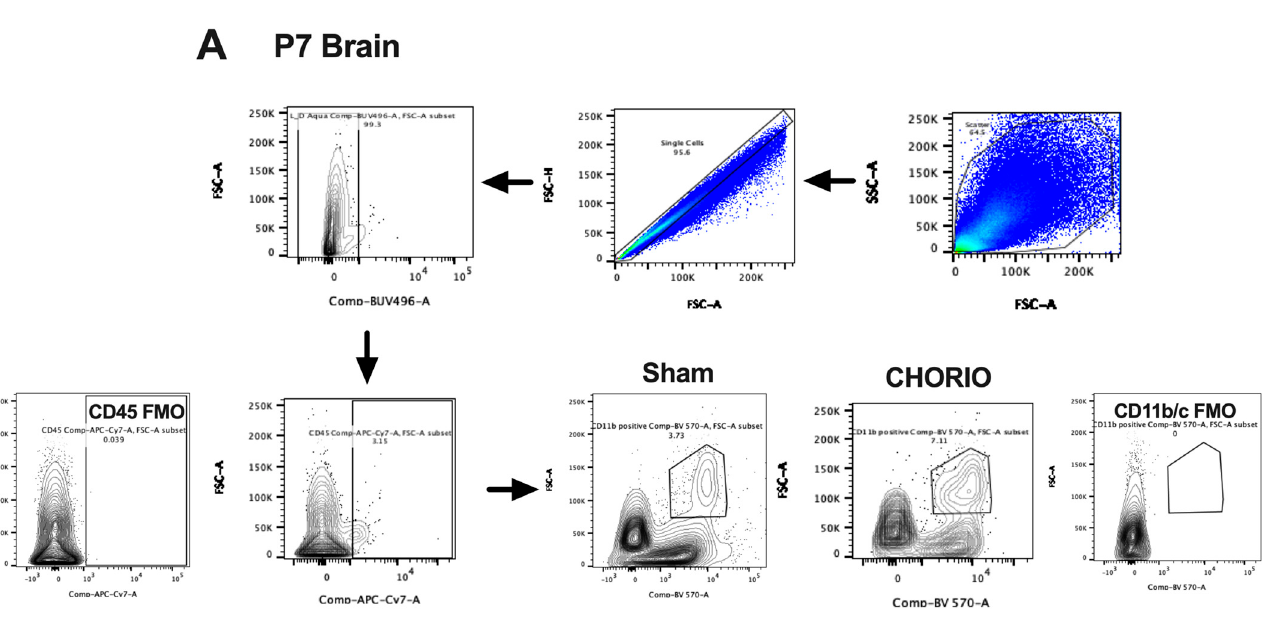
Figure 6. CHORIO-induced increase in brain mononuclear cells at P7. Single cells, live cells and CD45 + CD11b/c positive mononuclear cell population were identified by sequential gating. CD45 FMO and CD11b/c FMO controls were utilized to identify gating boundaries as shown in ( A ). No change in total CD45 + was detected between CHORIO and sham brains ( p > 0.05, not normally distributed, Mann–Whitney) ( B ). Significant increase in the percentage of CD45 + CD11b/c + mono- nuclear cells in CHORIO brains at P7 compared with sham (** p = 0.0098, normally distributed, Welch’s t -test, mean ± SEM), ( C ). 2.4. Peripheral Blood T Cell Composition at P21 after CHORIO Former preterm neonates who have CP have a persistent pro-inflammatory profile in peripheral blood at childhood [30]. Therefore, we set out to determine whether CHO- RIO in our model resulted in a pro-inflammatory adaptive immune programming at P21, at young adolescence. We measured adaptive immune responses in peripheral blood T cell subsets in sham and CHORIO pups at P21, a representative gating strategy is shown in Figure 7A. We did not detect significant alterations in percentages of gated peripheral blood T cell subsets, including CD45 + CD3 + lymphocytes, CD3 + CD4 + T helper (Th) cells,